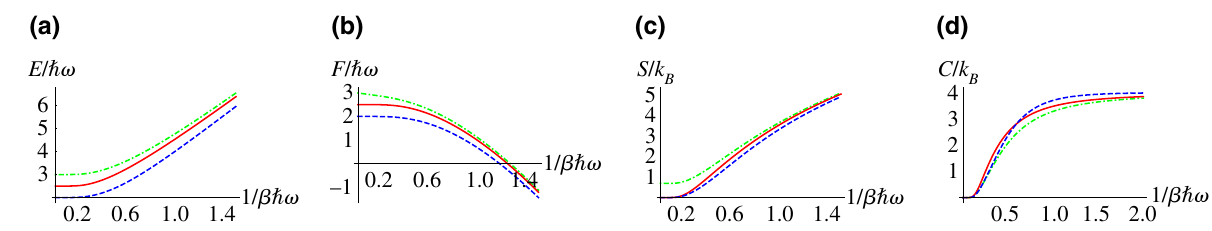
FIG. 5. Equilibrium (a) internal energy, (b) free energy, (c) entropy, and (d) heat capacity for two topological anyons with anyonic phase corresponding to ν = 0 (blue, dashed), ν = 1 / 2 (red, solid), and ν = 1 (green, dot dashed).